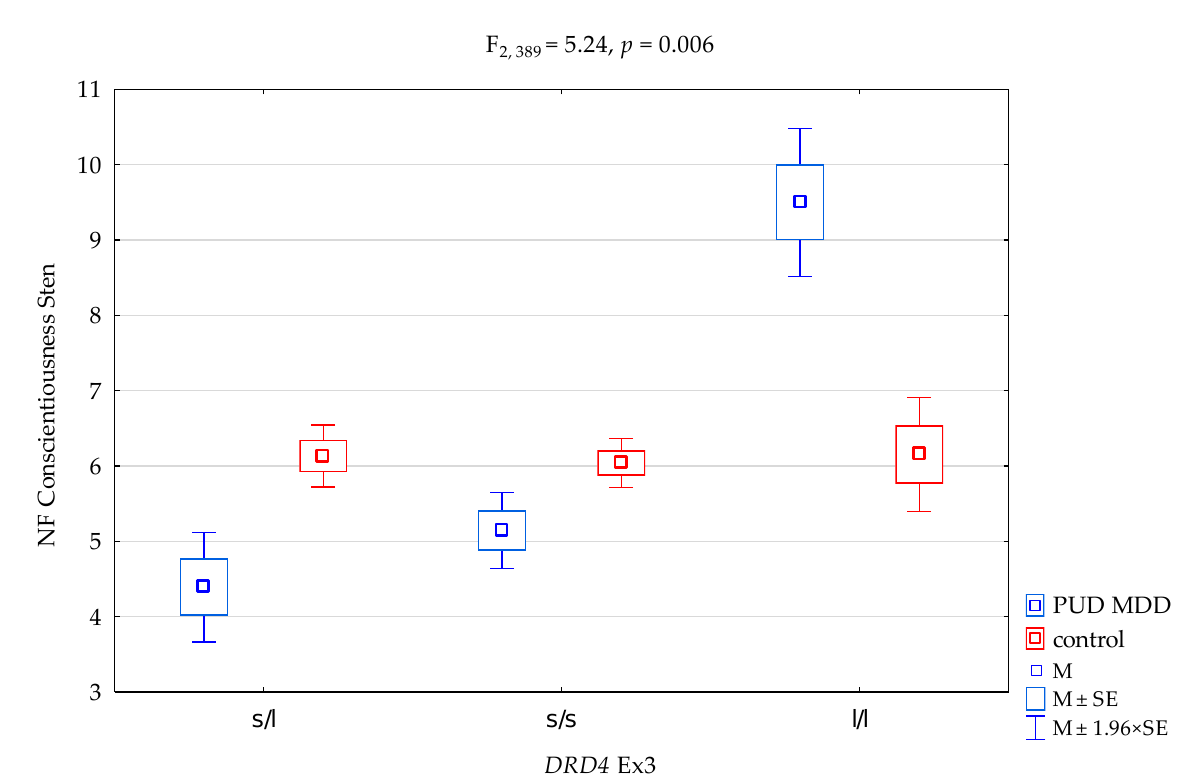
Figure 2. Interaction between patients with polysubstance use disorder comorbid with a depressive episode (PUD MDD)/control and DRD4 exon 3 ( DRD4 Ex3) and the NEO FFI Conscientiousness/scale. M, mean; SE, standard error. Table 7. Post hoc analysis of interactions between patients with polysubstance use disorder comorbid with a depressive episode (PUD MDD)/control and DRD4 exon 3 ( DRD4 Ex3) and the NEO FFI Extraversion/Conscientiousness Scale.